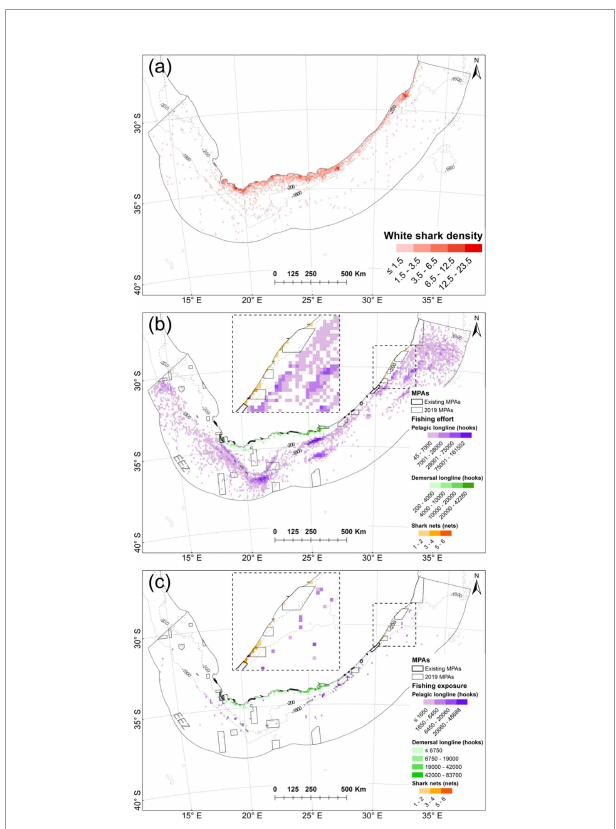
FIGURE 7 | (A) Normalized shark density in the South African EEZ between 2012 and 2014. (B) Total fi shing effort within the EEZ by fi shing sector between 2012 and 2014. (C) White shark fi shing exposure within the EEZ represented by fi shery sector. MPAs in existence during tracking are referred to as “ existing ” MPAs; others were proclaimed in 2019.